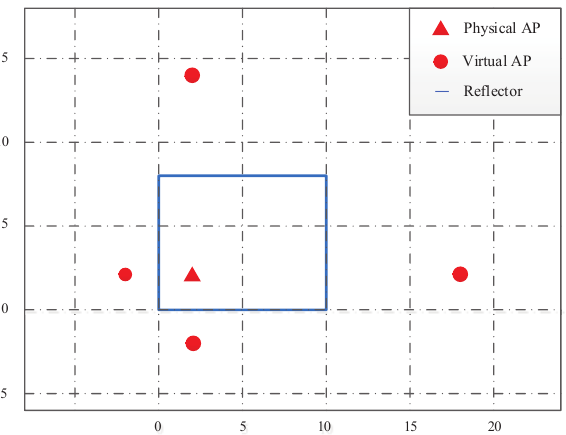
Figure 2. The two-dimension layout of the indoor mmW WLAN